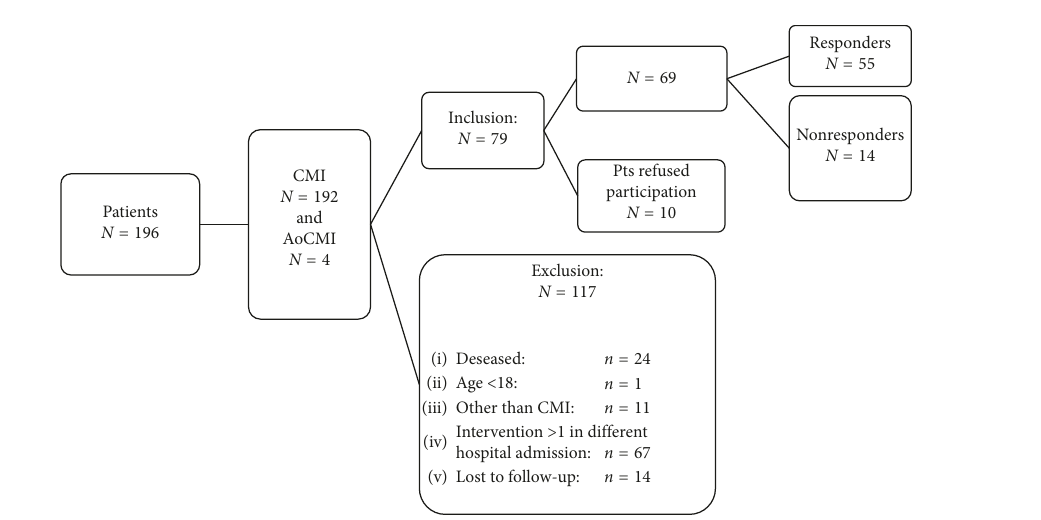
Figure 1: Flowchart of patient inclusion. Table 2: Patient characteristics of responding